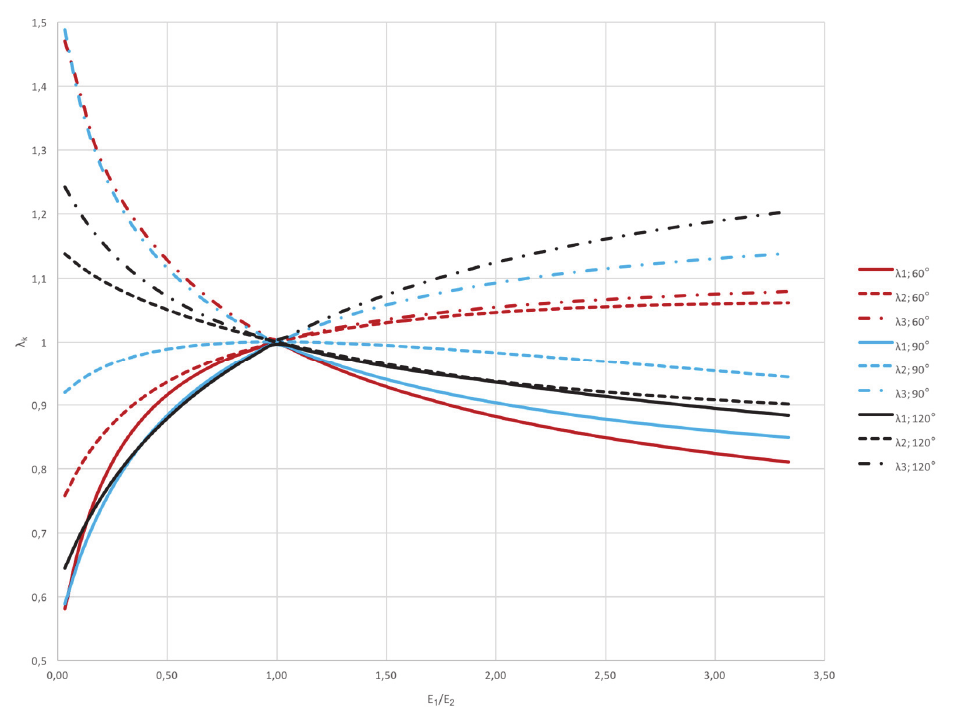
Figure 2: Dependence of  1 ,  2 and  3 on E 1 /E 2 shown for 3 SMI geometries  = 60°, 90°,